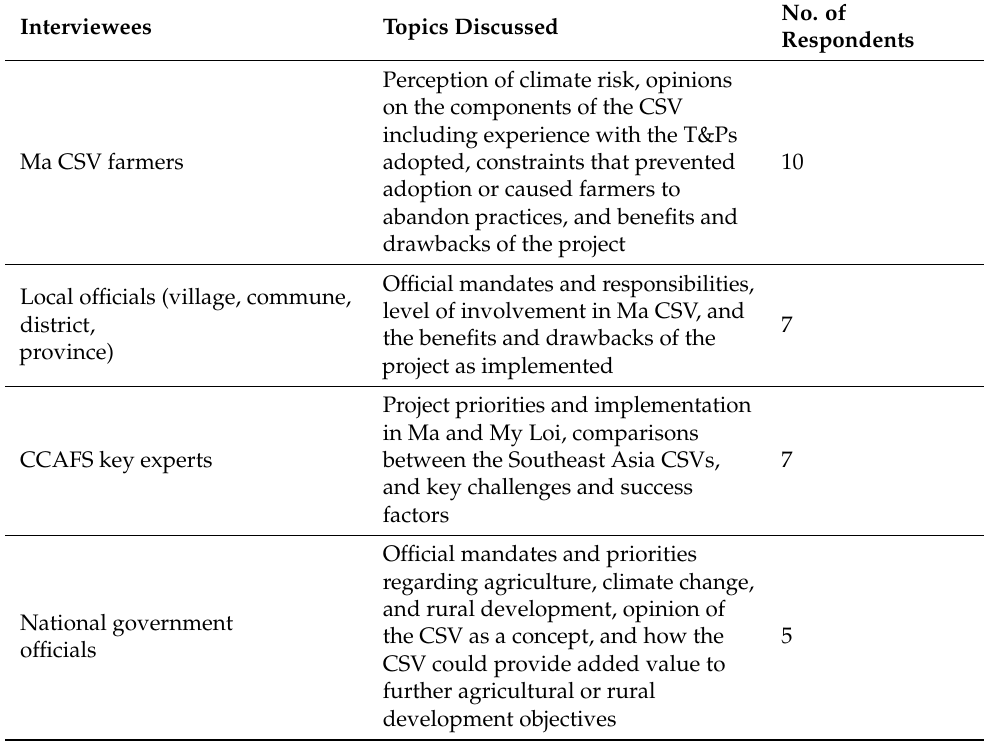
Table 1. Interviewees and topics